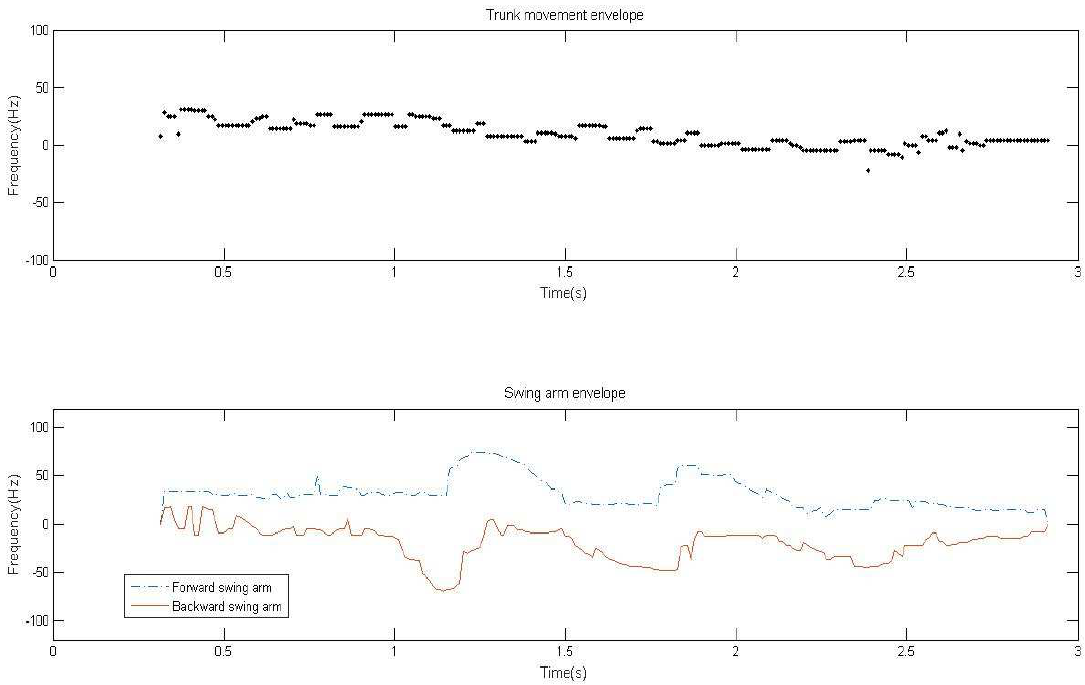
Figure 7. Two types